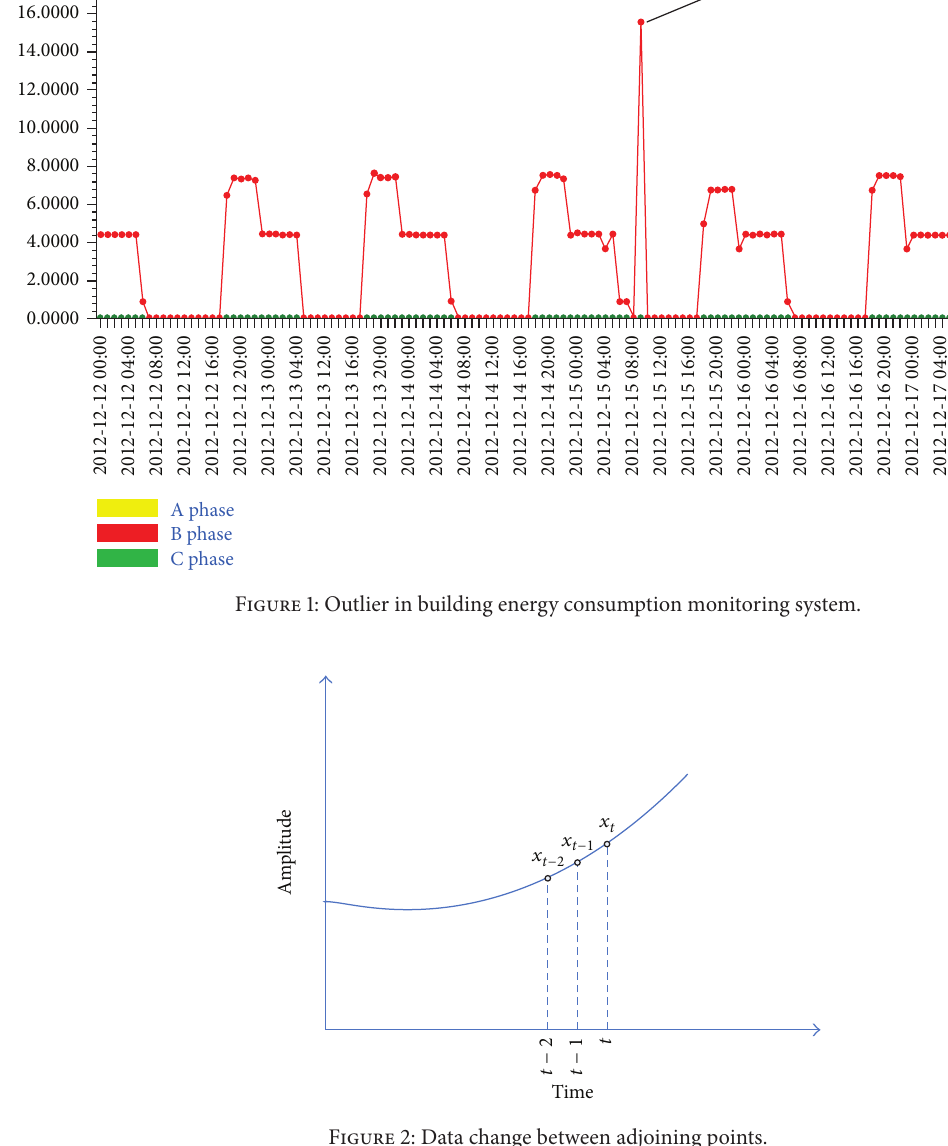
Figure 2: Data change between adjoining